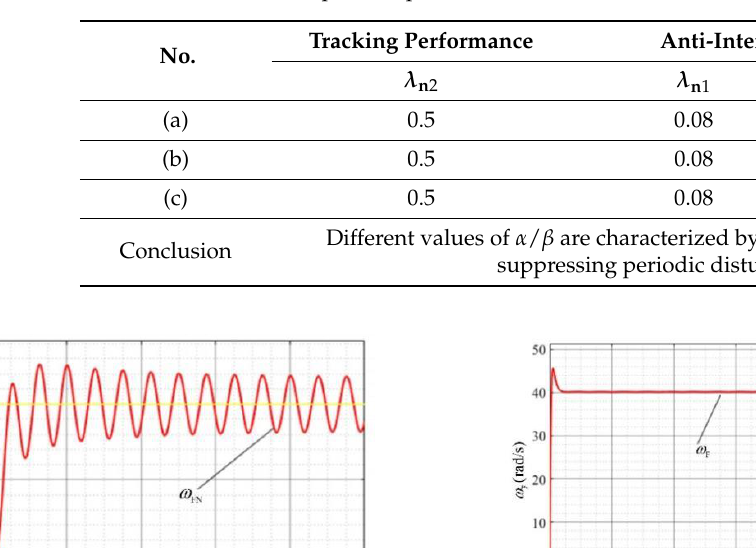
F  Figure 18. Experimental simulation model of drivetrain vibration suppression based on the 3-DOF- IMC of generator. * means the reference value. Parameters of the two-mass drivetrain are taken from Table 3 in [5]. The 3-DOF-IMC generator parameters are described in this section. Furthermore, the effect of the 𝐹 f (𝑠) parameters on the system is discussed.